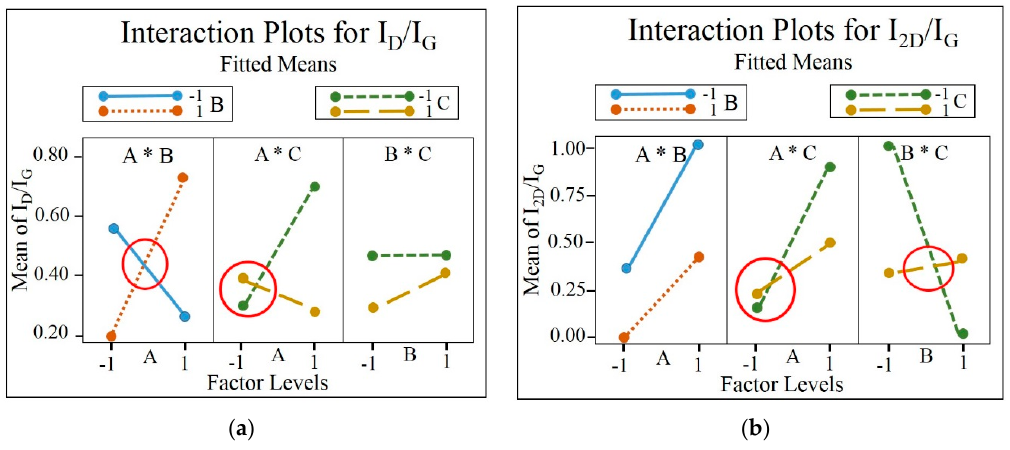
Figure 3. Interaction plots of the factors “A”, “B” and “C” for Response I ( a ) and Response II ( b ); solid circles indicate the interaction points. Factor interaction terms “AB” and “AC” are visible for Response I, while factor interaction terms “AC” and “BC” are visible for Response II.